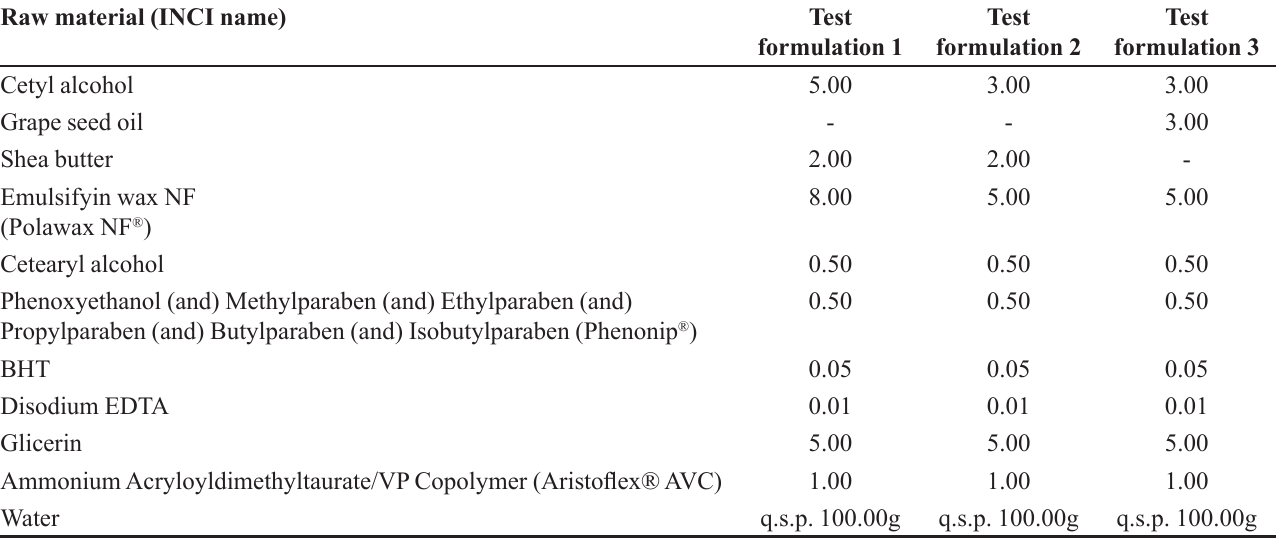
TABLE I - Percent composition (w/w) of test emulsions 1, 2 and 3 Raw material (INCI